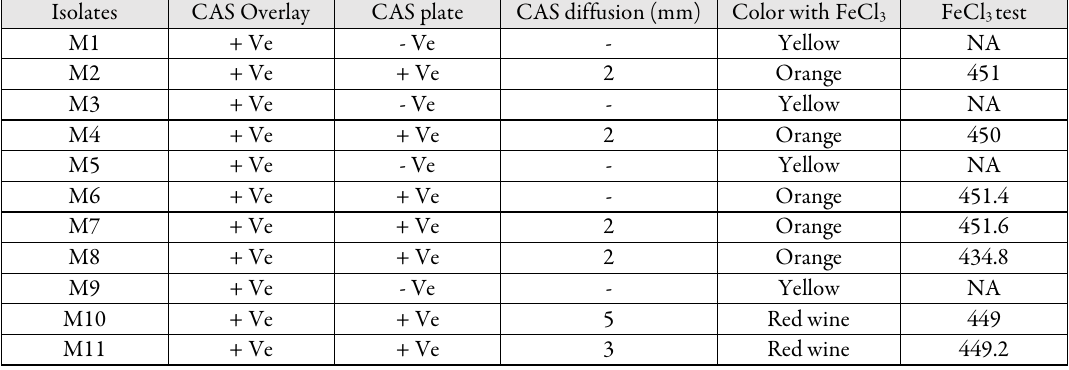
Table 1. Isolates showed positive for siderophore on CAS agar and their response to the FeCl 3